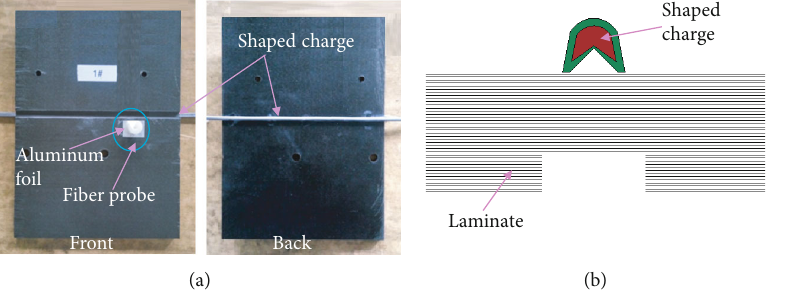
Figure 4: Cutting test and FEA model. (a) Cutting test for model veri fi cation [16]. (b) FEA model for veri fi cation.